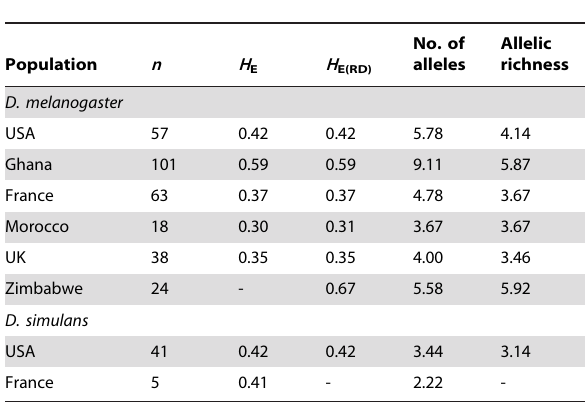
Table 2. Microsatellite diversity statistics within six D. melanogaster and two D. simulans